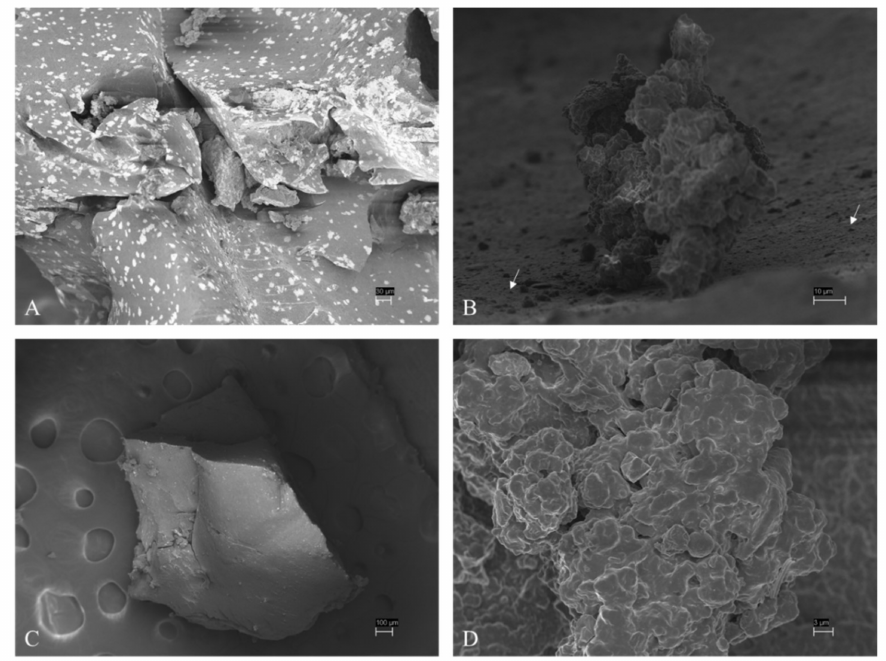
Figure 1. SEM analysis of both ELT-dg ( A , B ) and ELT-dp ( C , D ). There is wide range of sizes and shapes of selected materials, with nanoparticles (size < 1 µ m, based on classification proposed by Hartmann et al. [6] on plastic size) on the surface of a single ELT-dg ( B ) debris (indicated by arrows).